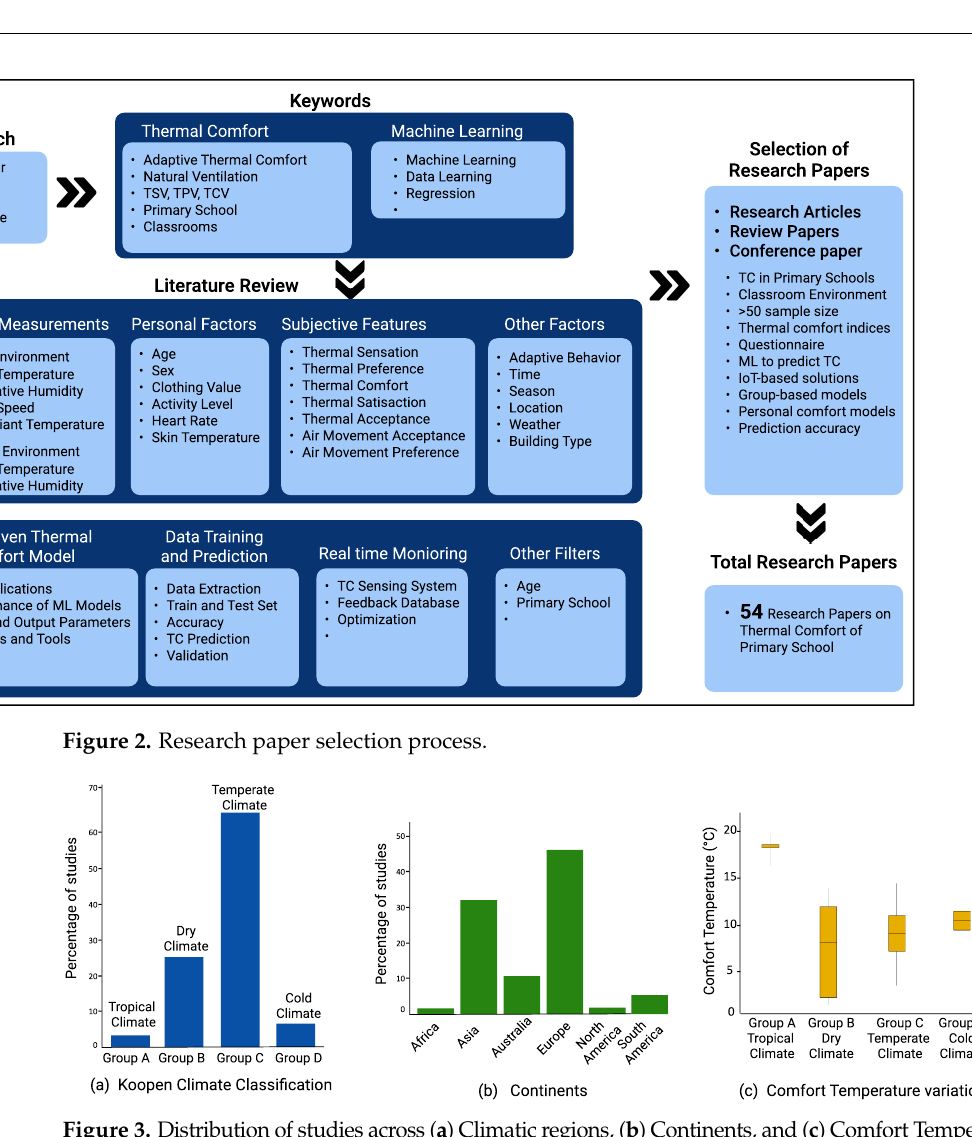
Figure 3. Distribution of studies across ( a ) Climatic regions, ( b ) Continents, and ( c ) Comfort Temperatures.